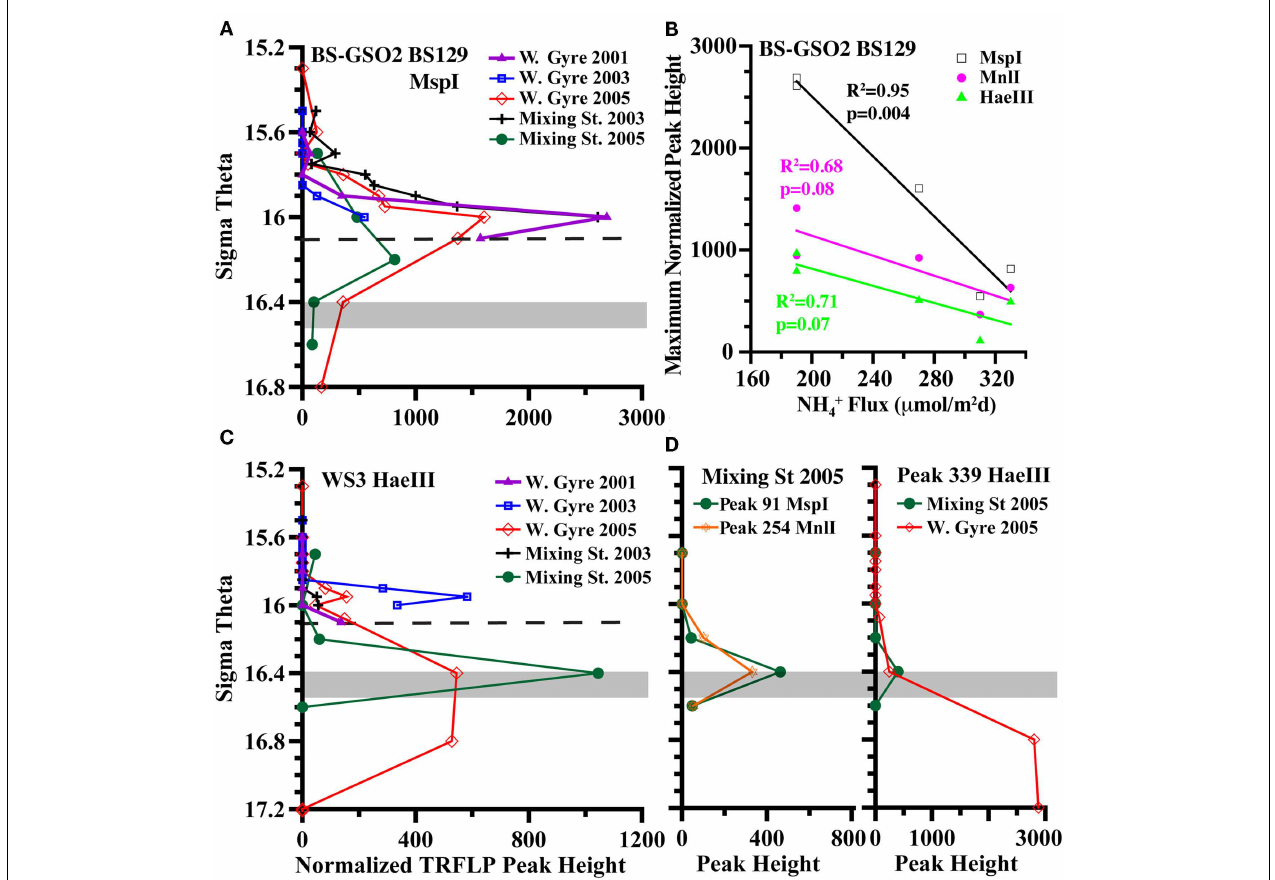
profiles of unidentified peak 91 from digestion with Msp I and peak 254 from digestion with Mnl I and peak 339 from digestion with Hae III. Dashed line indicates a typical depth for the shallowest detection of sulfide in theWestern Gyre.The gray box indicates the range of autotrophic denitrification activity seen in the Mixing Zone station in 2005 ( Figure 4